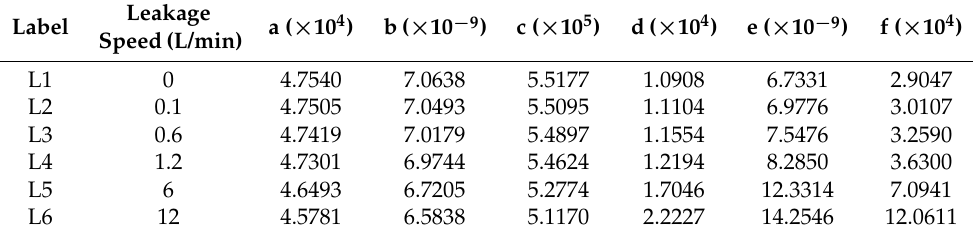
Table 8. Characteristic value of hydraulic cylinder leakage wavelet